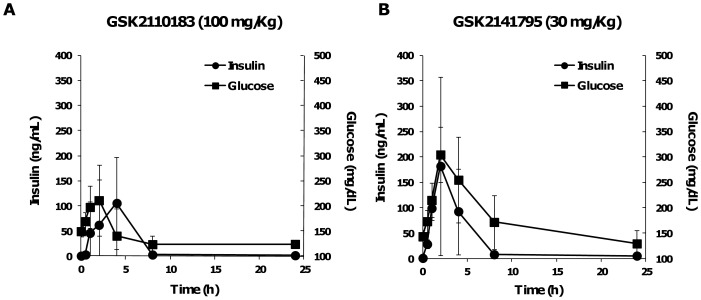
The impact of GSK2110183 and GSK2141795 on glucose homeostasis in vivo.Blood glucose (black squares) and plasma insulin (black circles) levels were assayed over time in mice treated with a single efficacious dose of GSK2110183 (30 mg/kg) or GSK2141795 (100 mg/kg). Data represents mean ± s.d.